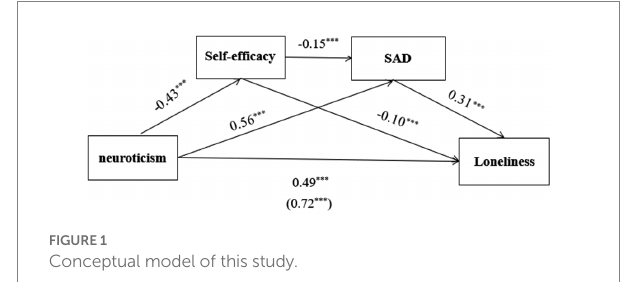
FIGURE 1 Conceptual model of this